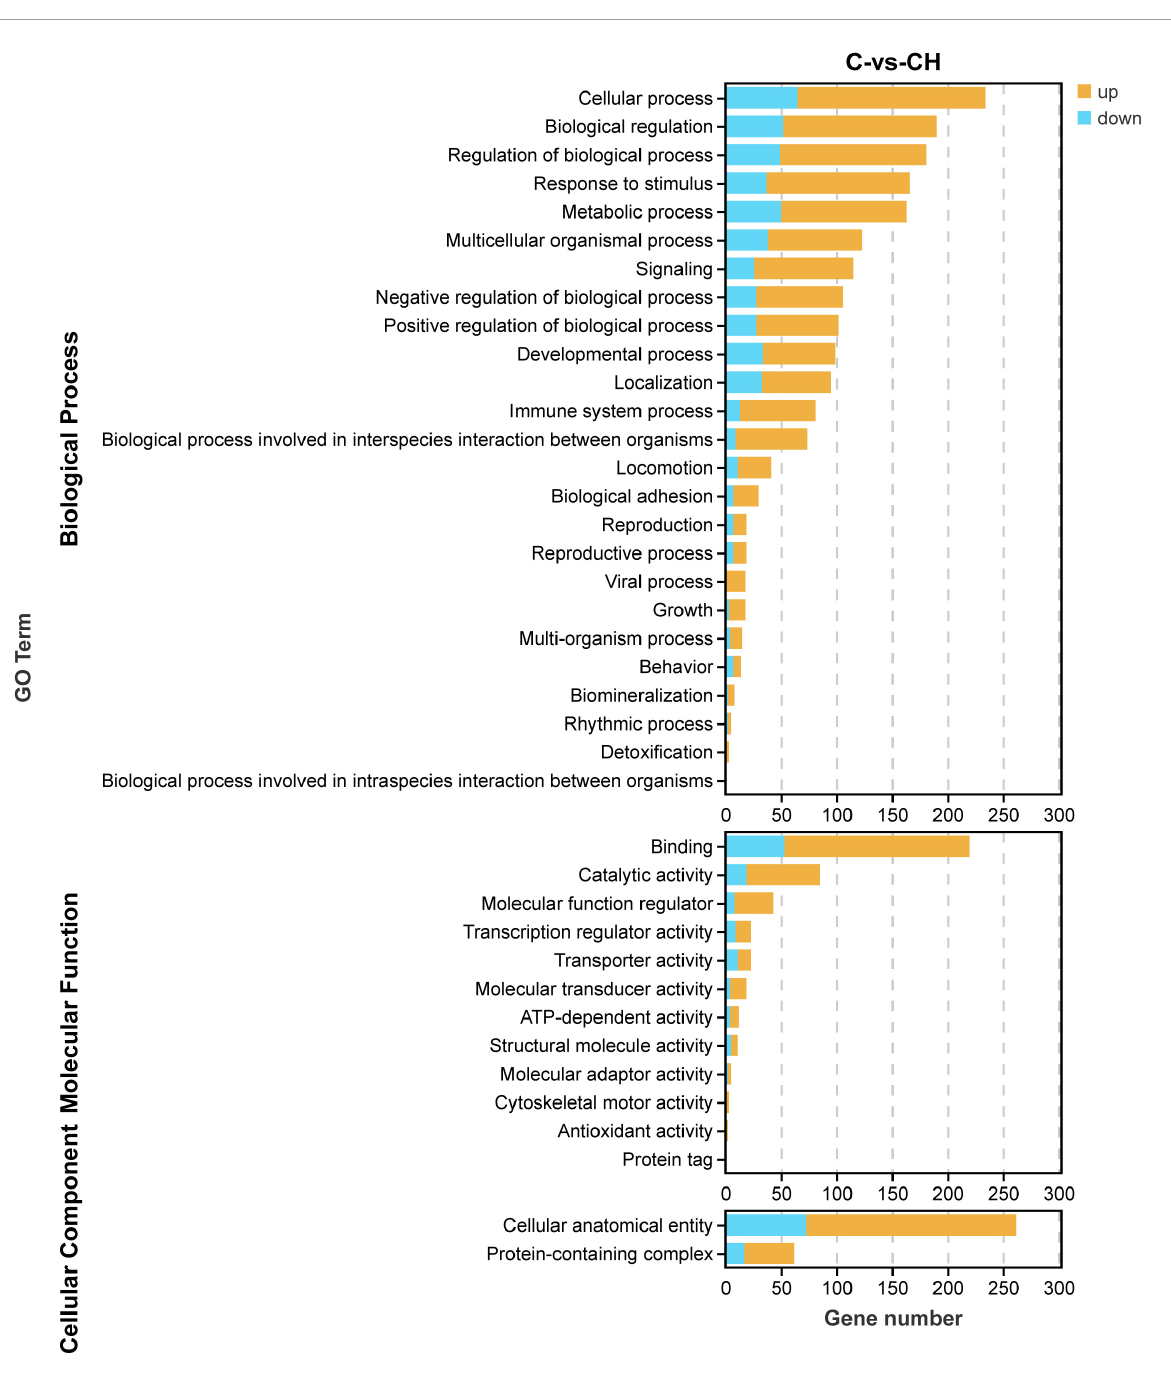
FIGURE5 Gene ontology analysis of DEGs in C-vs.-CH. C represents three untreated control samples; CH represents three chlorantraniliprole-treated treatment group samples.